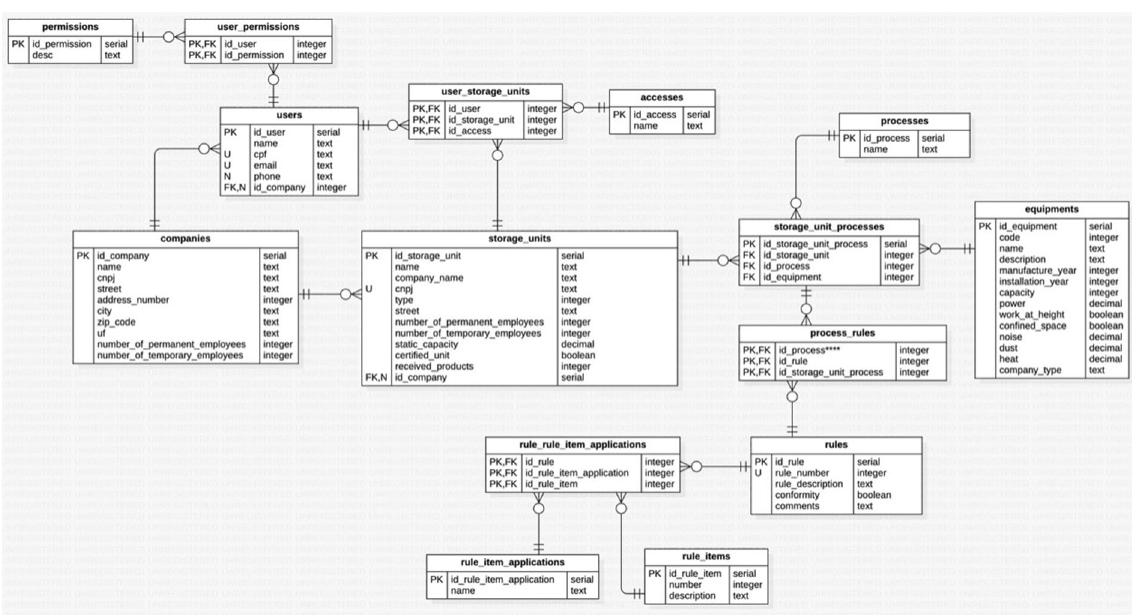
Figure 9. Algorithm simplified to manage occupational safety at grain handling and storage facilities chart flow.